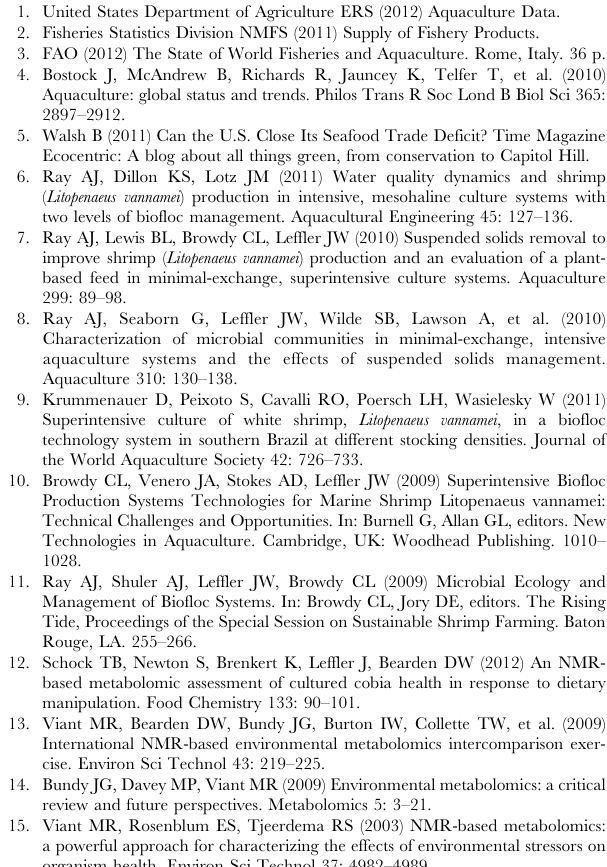
Figure S3 Shrimp growth. Growth curves from (A) the Nursery phase and (B) the Growout phase presented as means with 6 1 standard error of the mean. Figure S4 Visual for nursery metabolite changes. Nursery shrimp metabolite responses to a TAN spike event and time shown as relative integrated peak area for (A) amino acids and (B) nucleosides and nucleobases. Table S1 Water quality parameter summary. The mean 6 one standard deviation is provided for each parameter.